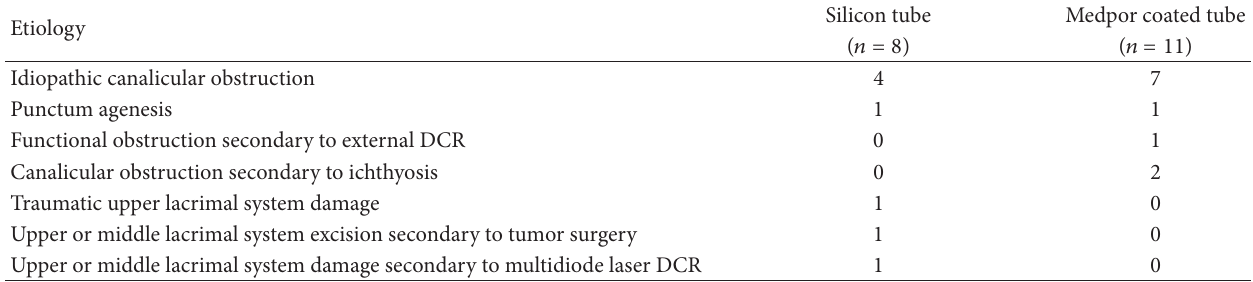
Figure 3: (a) The appearance at the postoperative month 6 of a patient who developed punctum secondary to ichthyosis and canalicular obstruction (the Medpor coated tube is in a suitable position and provides drainage). (b) Fifty-five-year-old female patient developed conjunctival irritation and conjunctival granuloma due to malposition of Medpor coated tube. (Due to ongoing complaints of the case, the tube was replaced). Table 2: Various etiologies of conjunctivodacryocystorhinostomy in the study and distribution thereof according to surgical technique ( 𝑛 : number of